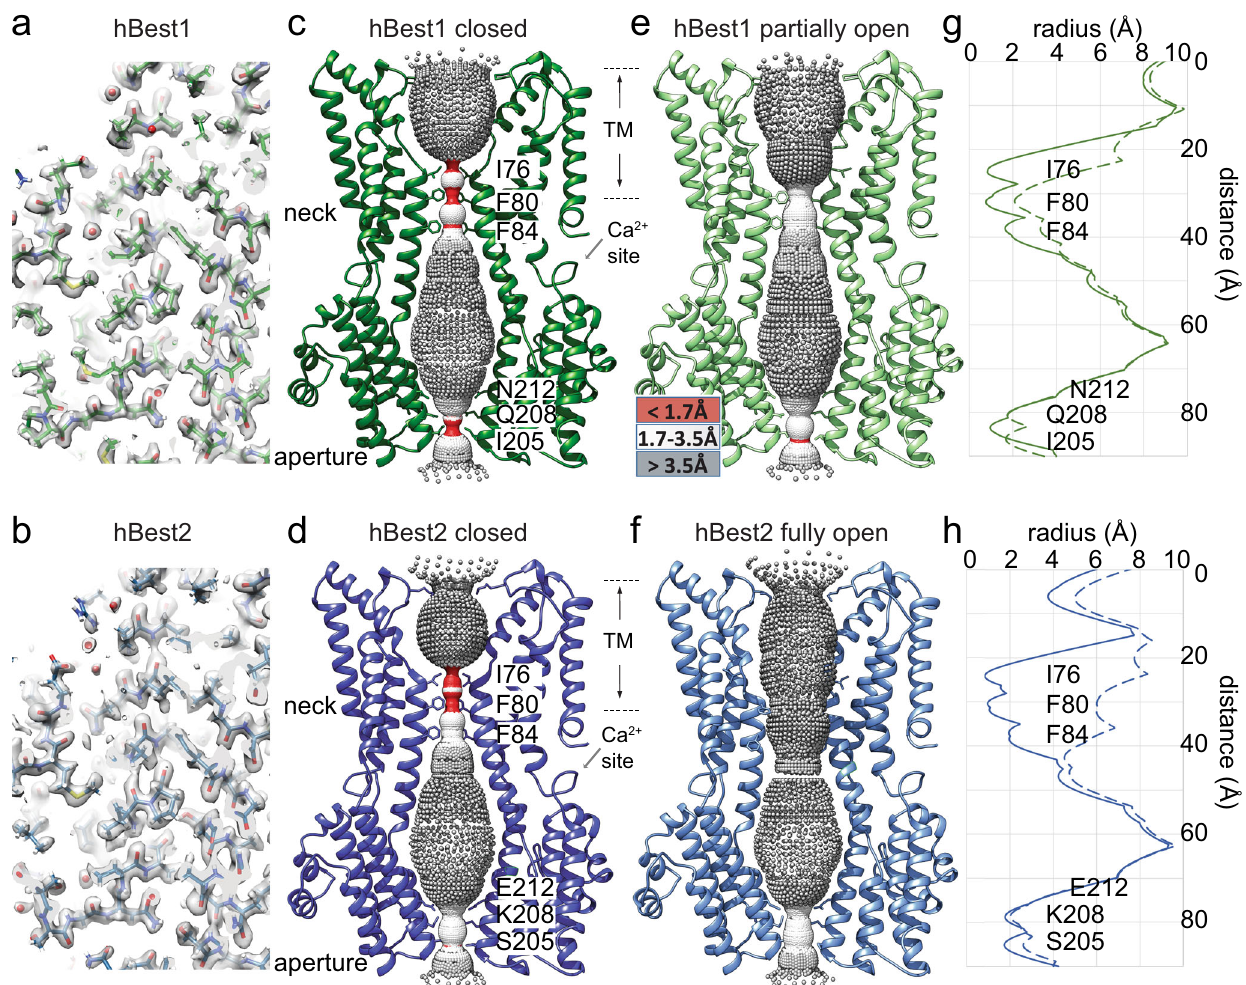
Fig. 1 Cryo-EM structures of hBest1 and hBest2 in different states. a , b Example densities from the Ca 2 + -bound (1 μ M) maps of hBest1 a and hBest2 b exhibiting high resolution features, including carbonyl groups, water molecules (red spheres), and holes in prolines. c – f Side view of two opposing (144°) protomers from hBest1 in the closed c or partially open e states and hBest2 in the closed d or fully open f states, with the ion permeation pathway visualized and pore diameter depicted as colored dots: the tighter the pore radius, the smaller and denser the dots. Inset , color key. Major constrictions to the ion permeation pathway are shown as sticks with residue labels on the right. Dashed lines indicate approximate boundaries of the transmembrane domains. g , h HOLE graph of the ion permeation pathway radius as a function of distance along the channel axis of hBest1 g and hBest2 h in the Ca 2 + - bound closed (solid lines) and partially/fully open (dashed lines) states. HOLE and Chimera are used to compute pore dimensions and visualize pore densities, respectively.